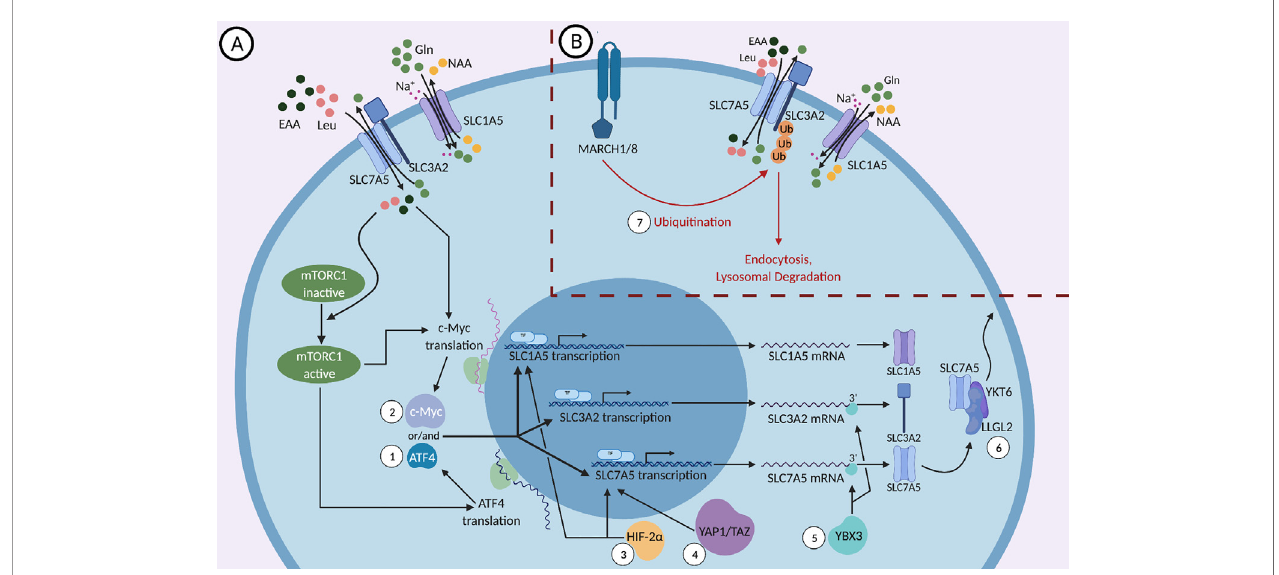
FIGURE 1 | (A) Positive and (B) negative molecular regulations of SLC1A5, SLC3A2, and SLC7A5. SLC3A2, a type II membrane protein, dimerizes with the nutrient transporter SLC7A5 to allow their localization to the plasma membrane. SLC1A5, the sodium dependent antiporter exchanges neutral amino acids (NAA) such as threonine, asparagine or serine for glutamine and the SLC3A2/SLC7A5 heterodimer exchanges glutamine for essential amino acids (EAAs), most importantly L- leucine. While the mTOR signaling pathway regulates the expression of SLC1A5, SLC3A2, and SLC7A5, these proteins can activate mTOR in a feed-forward mechanism through the in fl ux of essential amino acids (EAAs), especially leucine. (1) mTORC1 regulates the translation and stability of the mRNA encoding the transcription factor ATF4, which in turn controls the transcription of SLC1A5, SLC3A2 , and SLC7A5 . (2) mTORC1 and the in fl ux of EAAs regulate the expression of the transcription factor c-Myc, which binds the promoters of SLC1A5 and SLC7A5 genes and upregulates their expression. (3) HIF-2 a , a transcription factor that is activated in response to hypoxic conditions, binds to the promoter of SLC1A5 and SLC7A5 and activates their transcription. (4) YAP1 and TAZ bind to the promoter of SLC7A5 and activate its transcription. (5) The DNA- and RNA-binding protein YBX3 enhances the stability of SLC7A5 and SLC3A2 transcripts by binding directly to their 3 ’ UTRs and prevents their degradation. (6) Under nutrient stress, LLGL2 forms a trimeric complex with SLC7A5 and a regulator of membrane fusion, YKT6, allowing for the surface localization of SLC7A5 and thereby promoting cellular proliferation. (7) MARCH1 and MARCH8 ubiquitin ligases lead to the direct ubiquitination of SLC3A2 and its degradation by endosomes and